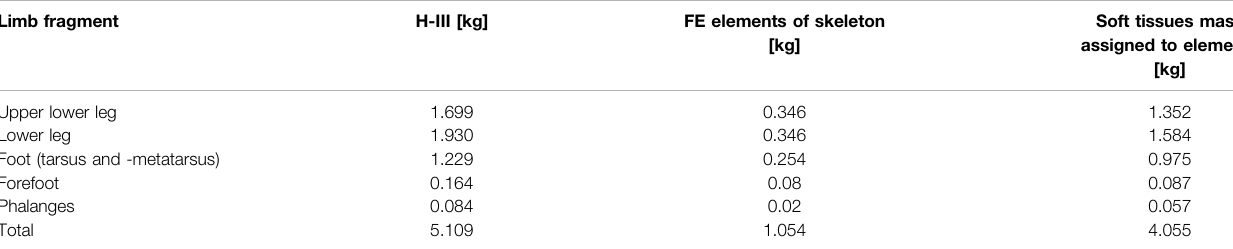
TABLE 2 | Additional mass assigned to